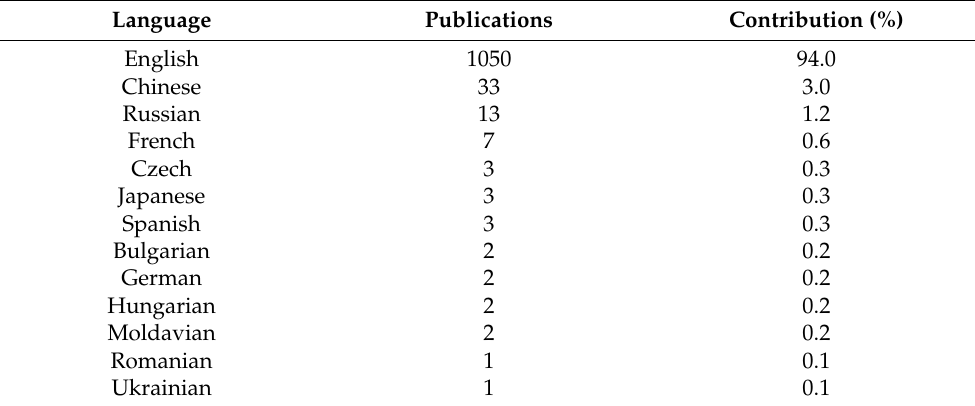
Table 1. The languages employed by the